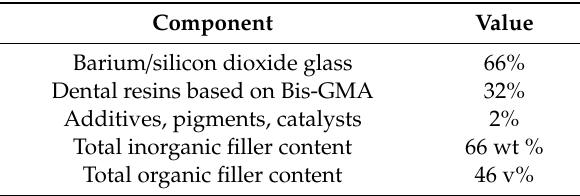
Table 1. Typical composition (experimental